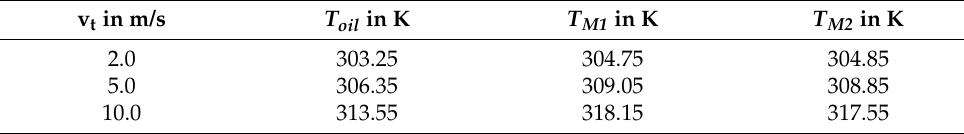
Table 2. Measured oil and component temperatures for different speeds at no-load [21]. v t in m/s T oil in K T M1 in